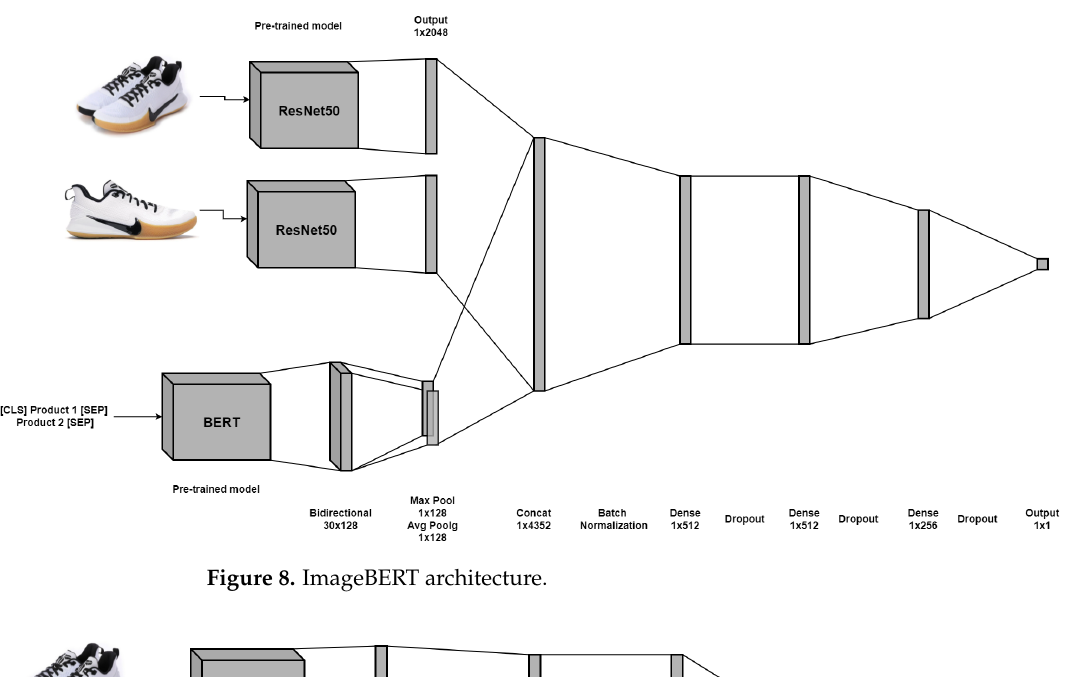
Figure 8. ImageBERT architecture.